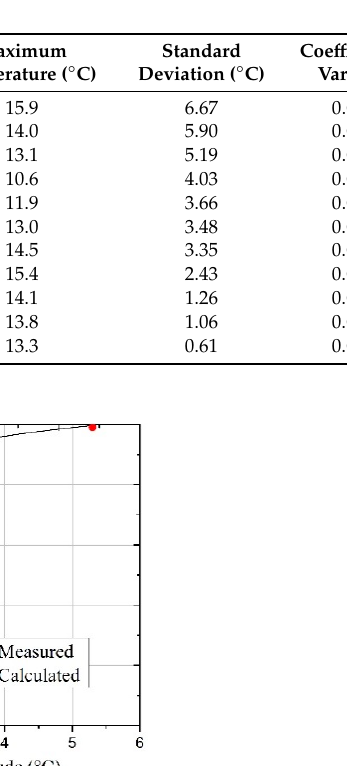
Table 3. Daily temperature characteristics calculated for different depths. The coefficient of variation is calculated based on the Kelvin temperature scale.